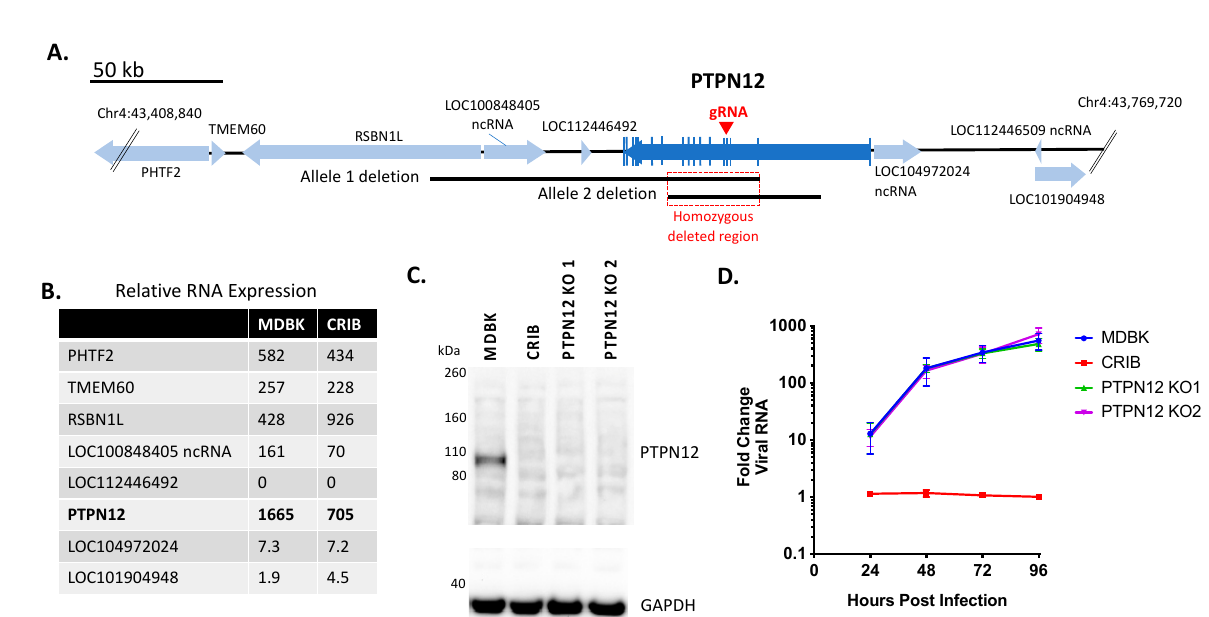
Figure 2. Knockout of PTPN12 does not significantly impact BVDV infection in MDBK cells. Panel ( A ), map of bovine PTPN12 and surrounding genes: blue arrows, genes (open reading frames); vertical blue lines, coding regions (exons); black lines, heterozygous deletions in two alleles of PTPN12 on chromosome 4; red square, homozygous deleted region (33,808 bp); red arrow, exon target of PTPN12 gRNA. Panel ( B ), RNASeq analyses of relative RNA transcript abundance in MDBK and CRIB cells (trimmed mean of M (TMM) normalization value). Panel ( C ), western blot of SDS-PAGE for PTPN12 and GAPDH (loading control). Panel ( D ), Multistep virus growth curve. Cells were infected with BVDV strain NADL (MOI 0.01). Cells were collected and processed 0–96 h post-infection for quantitation of viral RNA using RT-qPCR. Results represent the mean ± standard deviation ( n =